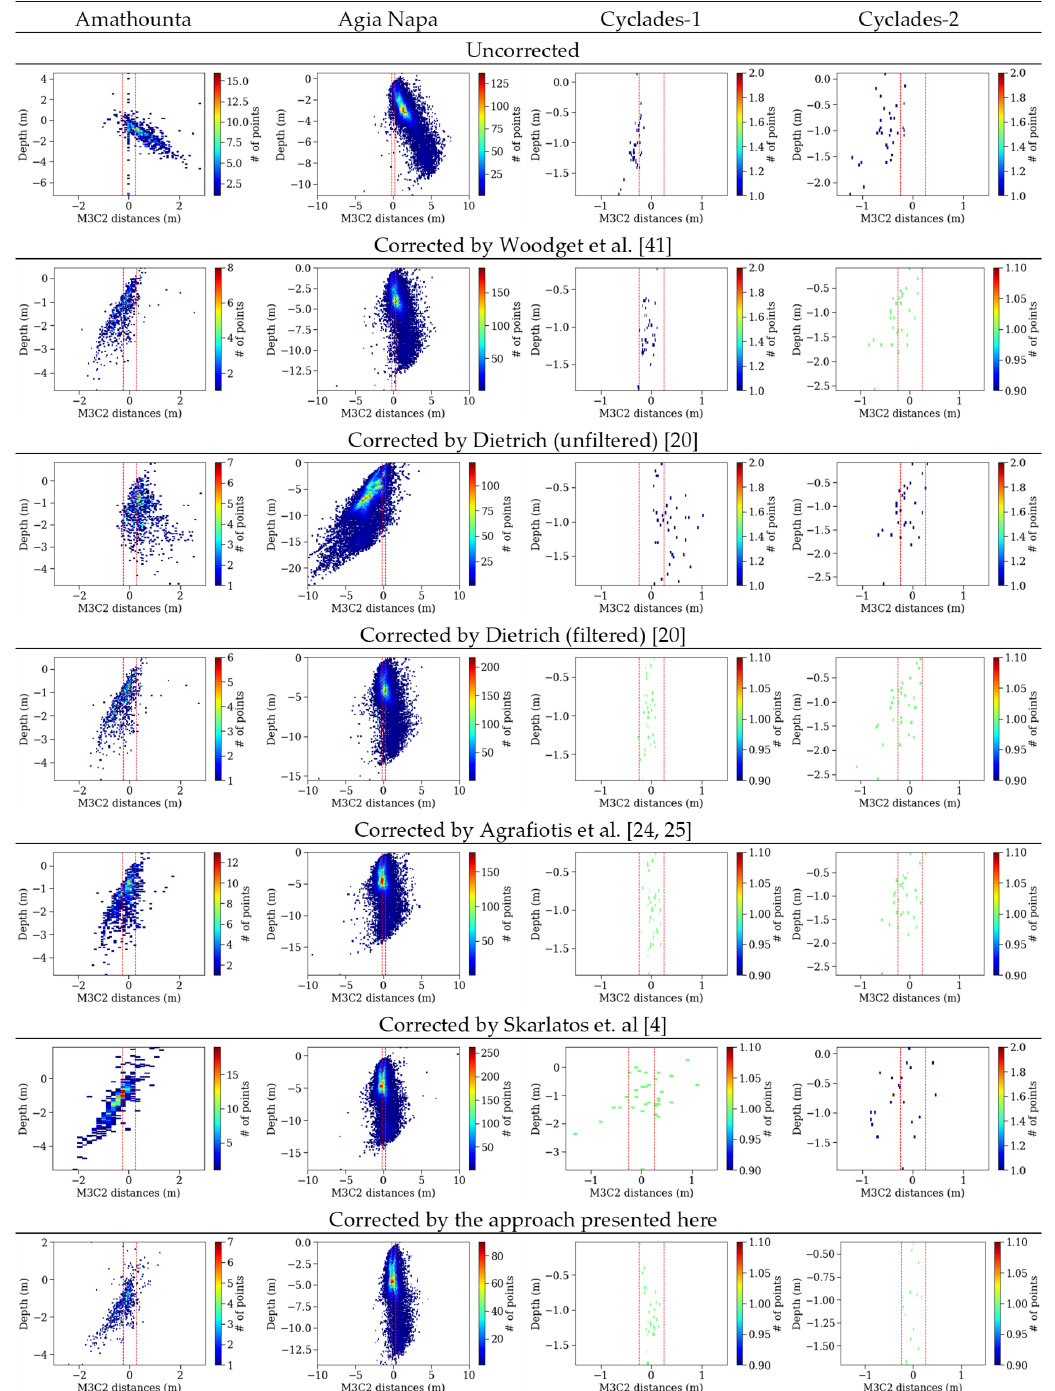
Figure 8. The histograms of the M3C2 distances between the ground truth and the uncorrected and corrected image-based sparse point clouds derived from the SfM for Amathounta (first column), Agia Napa (second column), Cyclades-1 (third column), and Cyclades-2 (fourth column) test sites, respectively. The dashed lines in red represent the accuracy limits generally accepted for hydrography, as introduced by the International Hydrographic Organization (IHO) [43]. M3C2 distances are in meters.